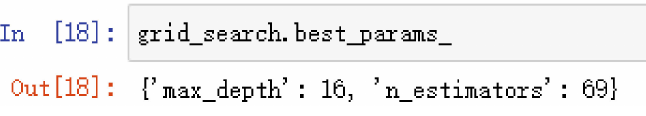
Figure 5. Maximum Depth and Number of Decision Trees.